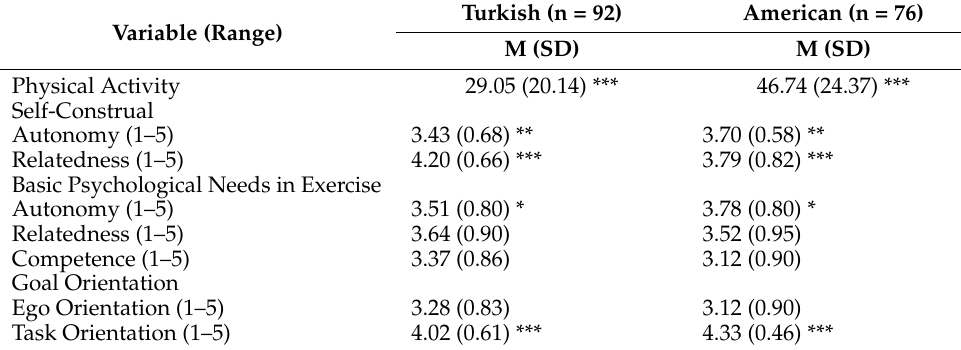
Table 1. Descriptive Statistics and Differences between Turks and Americans in terms of self- construals, basic psychological needs in exercise, goal orientation, and Physical Activity.